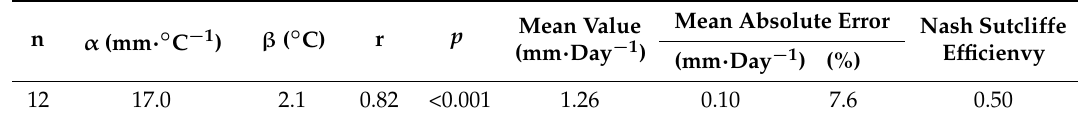
Table 2. Snowmelt and peak surface runoff model